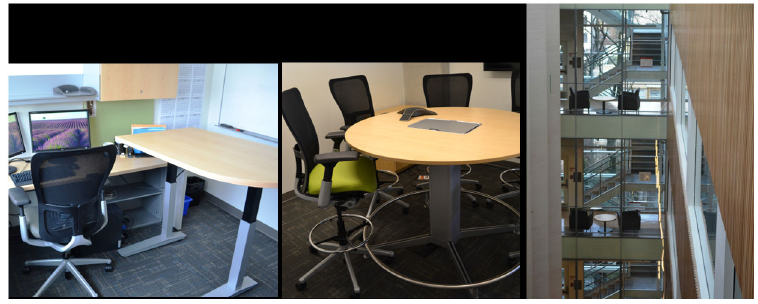
Figure 1. Some of the features of the new ‘activity permissive’ building. Specific features included adjustable standing desks, café-style meeting rooms with options to sit or stand, and glass staircases to maximize light and visibility. doi: